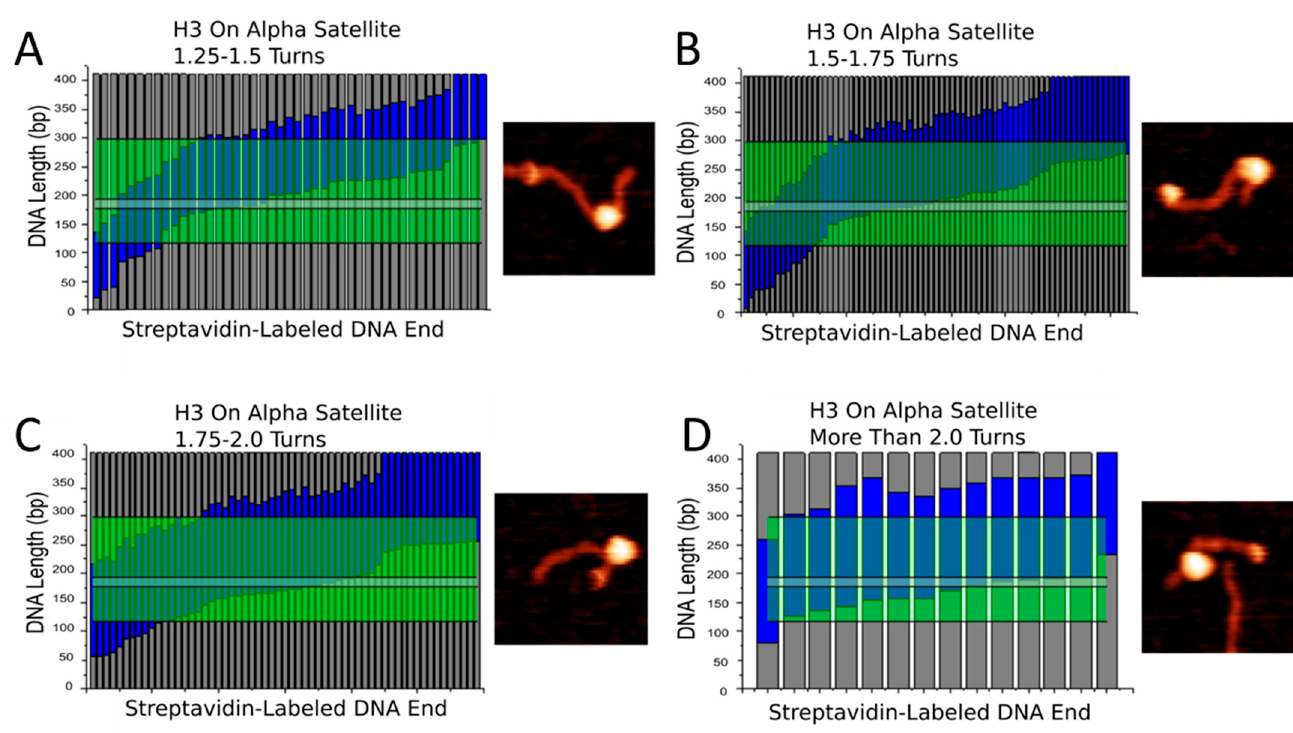
Figure 8. Mapping of H3 nucleosome position on the α -satellite substrate based on wrapping efficiency. Each bar denotes a single nucleosome. Dark gray regions indicate free DNA flanks. Blue regions indicate DNA wrapped around nucleosome core. Green regions indicate the position of the α -satellite motif. Thin gray line indicates position of the CENP-B box. Representative image of nucleosome with corresponding wrapping efficiency shown to the right of each map. ( A ) Under wrapped nucleosomes. ( B ) Fully wrapped nucleosomes. ( C , D ) Over wrapped nucleosomes.